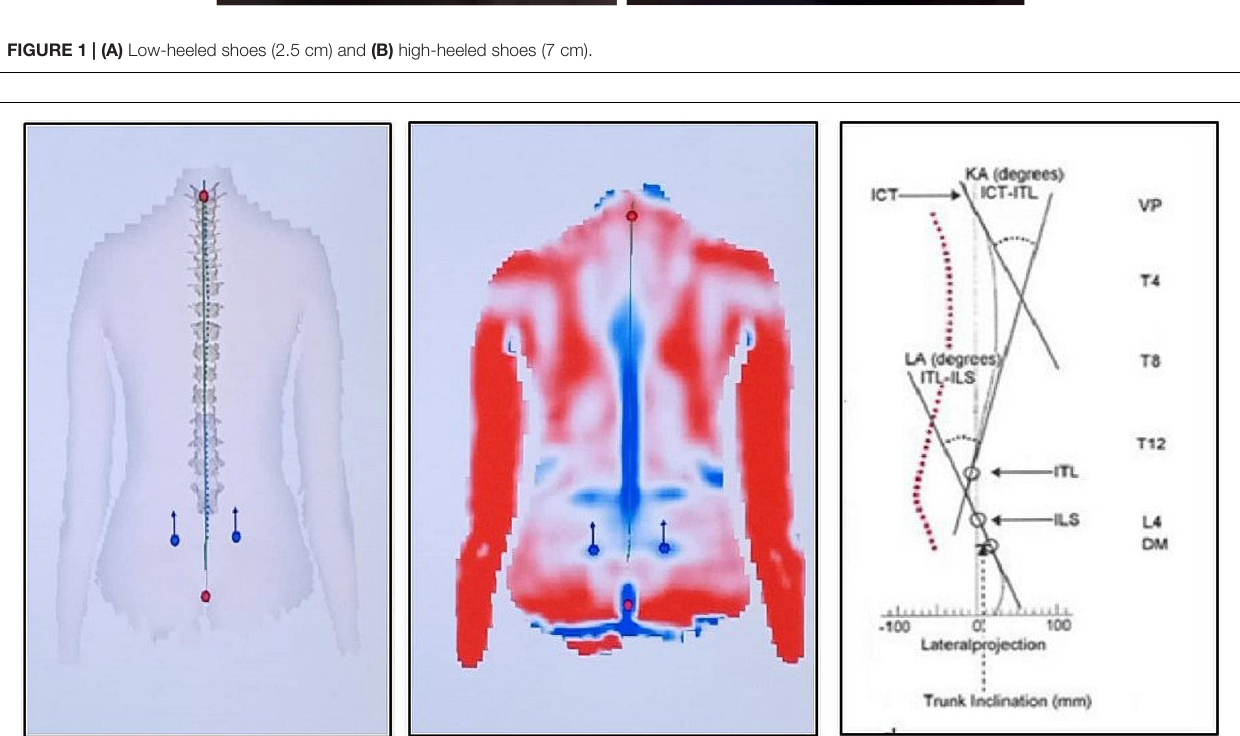
FIGURE 2 | Illustrations of the shape of the spine and pelvis obtained from the DIERS formetric 3D system. The right image illustrates the sagittal profile of kyphotic angle (KA), lordotic angle (LA), trunk inclination (TI), cervicothoracic inflection point (ICT), thoracolumbar inflection point (ITL), and lumbosacral inflection point (ILS) (Schröder et al., 2019). The middle image illustrates the back surface reconstruction with red regions (convex curvature), blue regions (concave curvature), red dots referring to the vertebra prominence (VP), and blue dots referring to right and left lumbar dimples (DR and DL). The left image illustrates the frontal plane spine